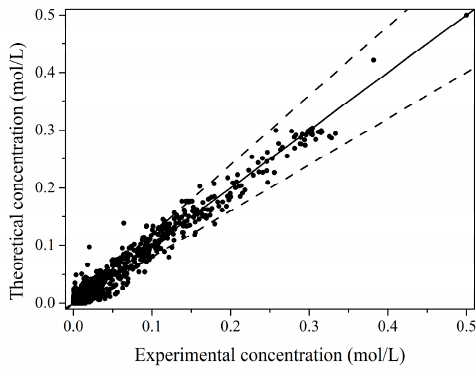
Figure 4. Parity plot between experimental and theoretical concentrations (Dashed lines: ± 20% standard deviation).